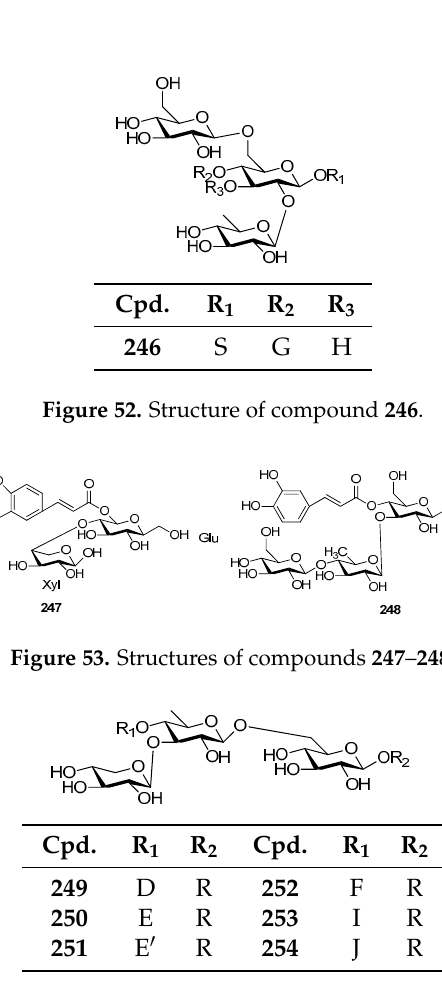
Figure 54. Structures of compounds 249 – 254